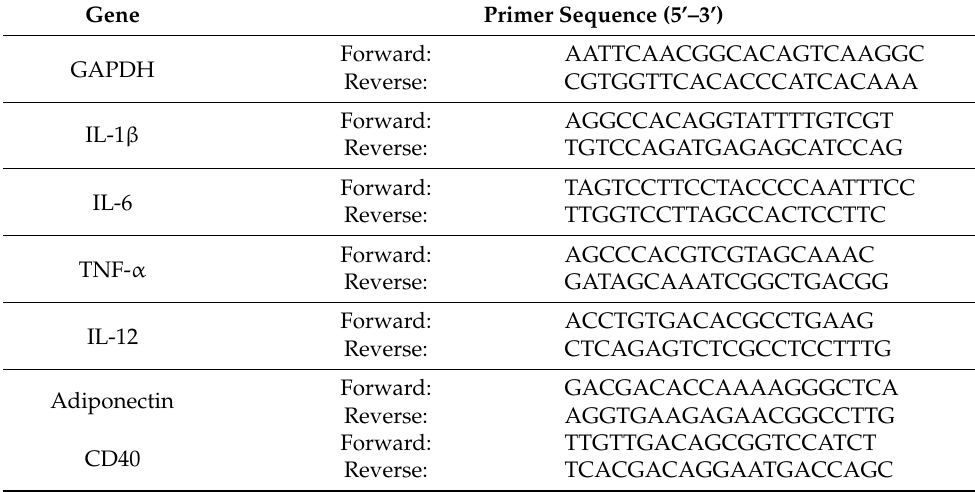
Table 3. Primer sequences used for